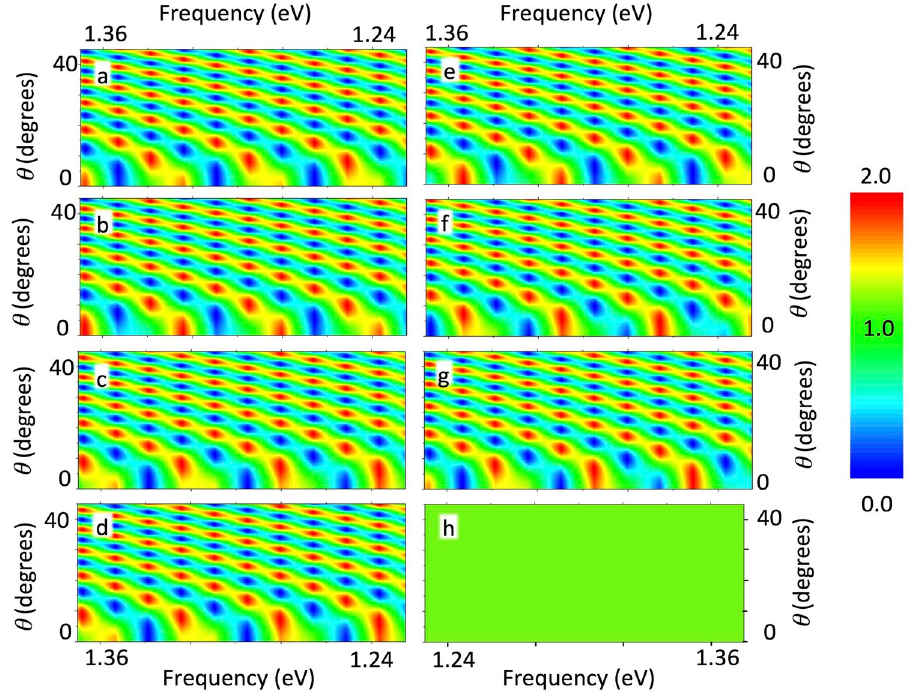
Figure 7. Dependence of the modal Purcell factor on frequency and direction of emission for a different position from the interface: ( a ) 17 nm; ( b ) 28 nm; ( c ) 35 nm; ( d ) 56 nm; ( e ) 71 nm; ( f ) 93 nm; ( g ) 142 nm; for the slab of GaAs of the thickness 28 μ m surrounded by air. The Fig. 7 ( h ) demonstrates the pattern of modal Purcell factor averaged over the distance of the emitter from the interface on the interval corresponding to one